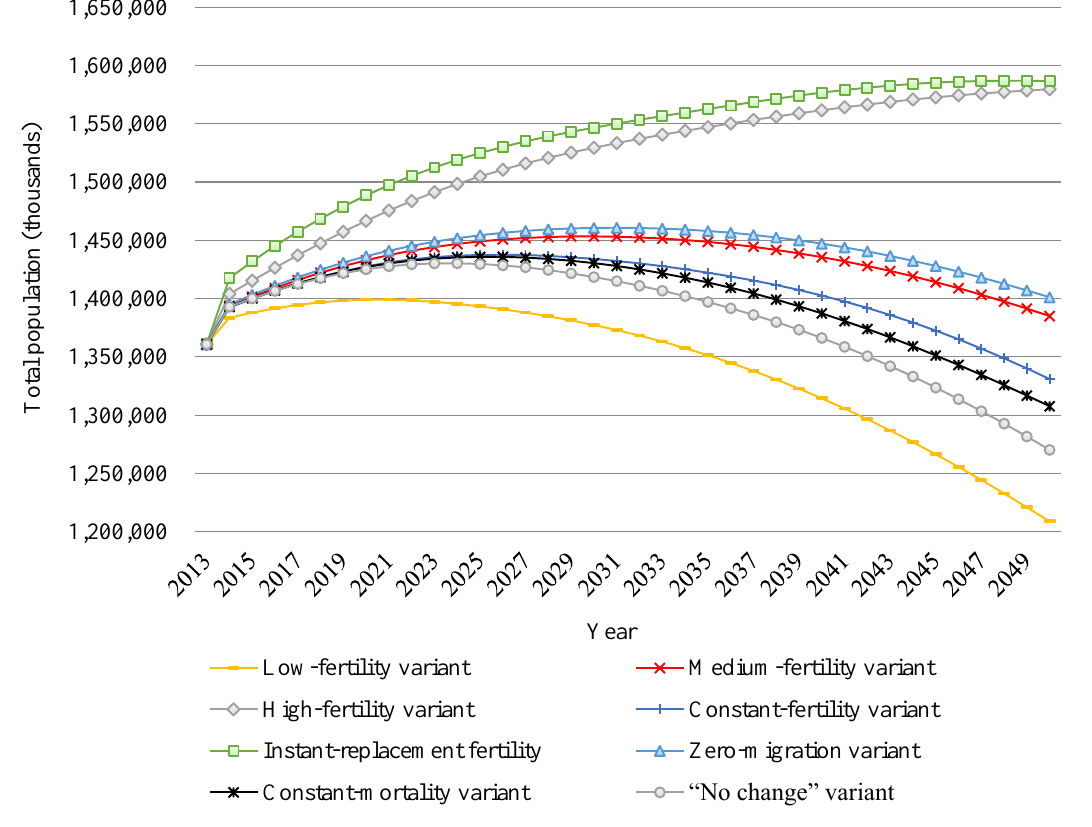
Figure 15. Annual population of China under varying fertility trends (data source: